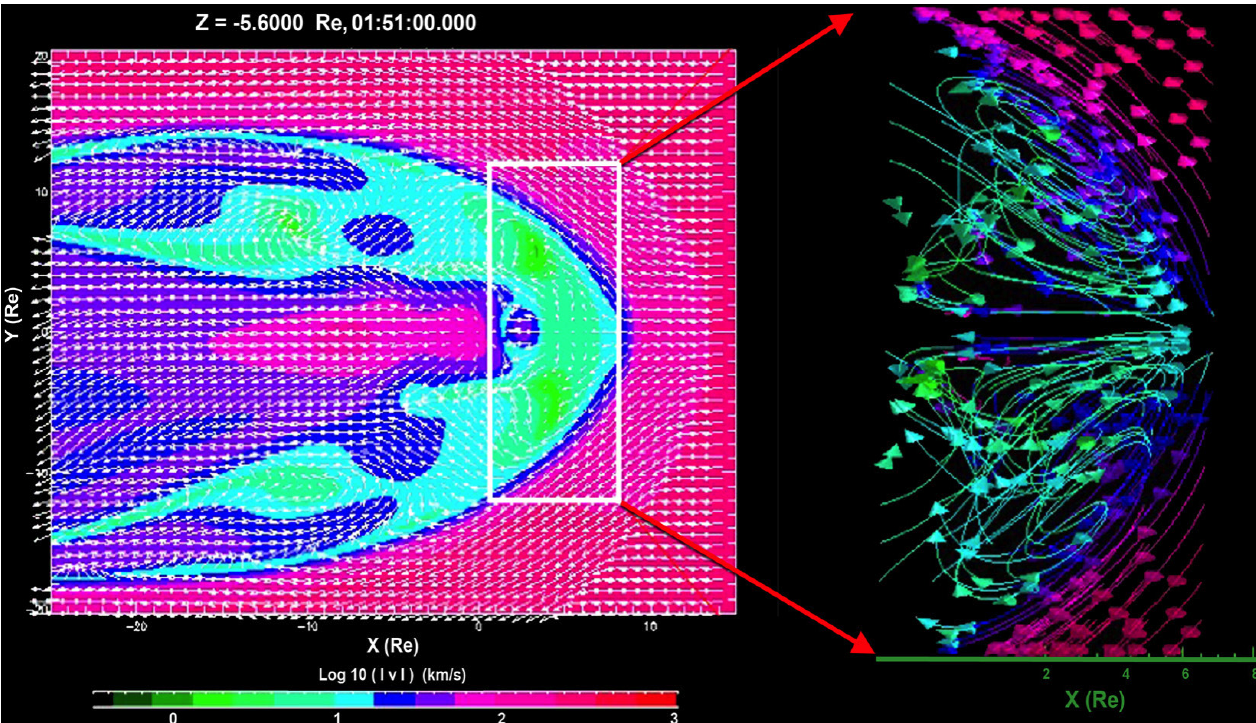
Fig. 8. Dawn and dusk vortices found simultaneously rotating counterclockwise(dawn) and clockwise(dusk). These vortices came in pairs with the ones shown in Fig. 7. The rotation direction is determined by following the arrowheads from the streamlines from the positive y axis. The vortices are located in the same z = − 5 . 6 R E , but the dawn dayside on x = 3 . 8 R E , y = − 7 . 2 R E , and the dusk dayside on x = 2 . 6 R E , y = 6 . 8 R E